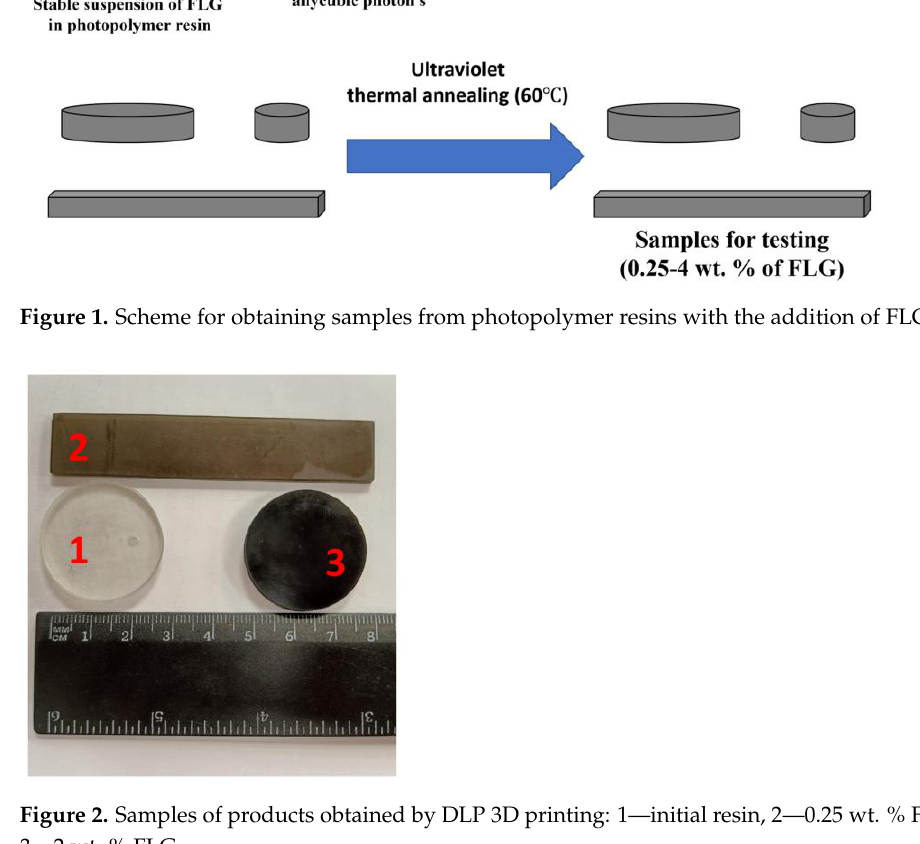
Figure 1. Scheme for obtaining samples from photopolymer resins with the addition of FLG.